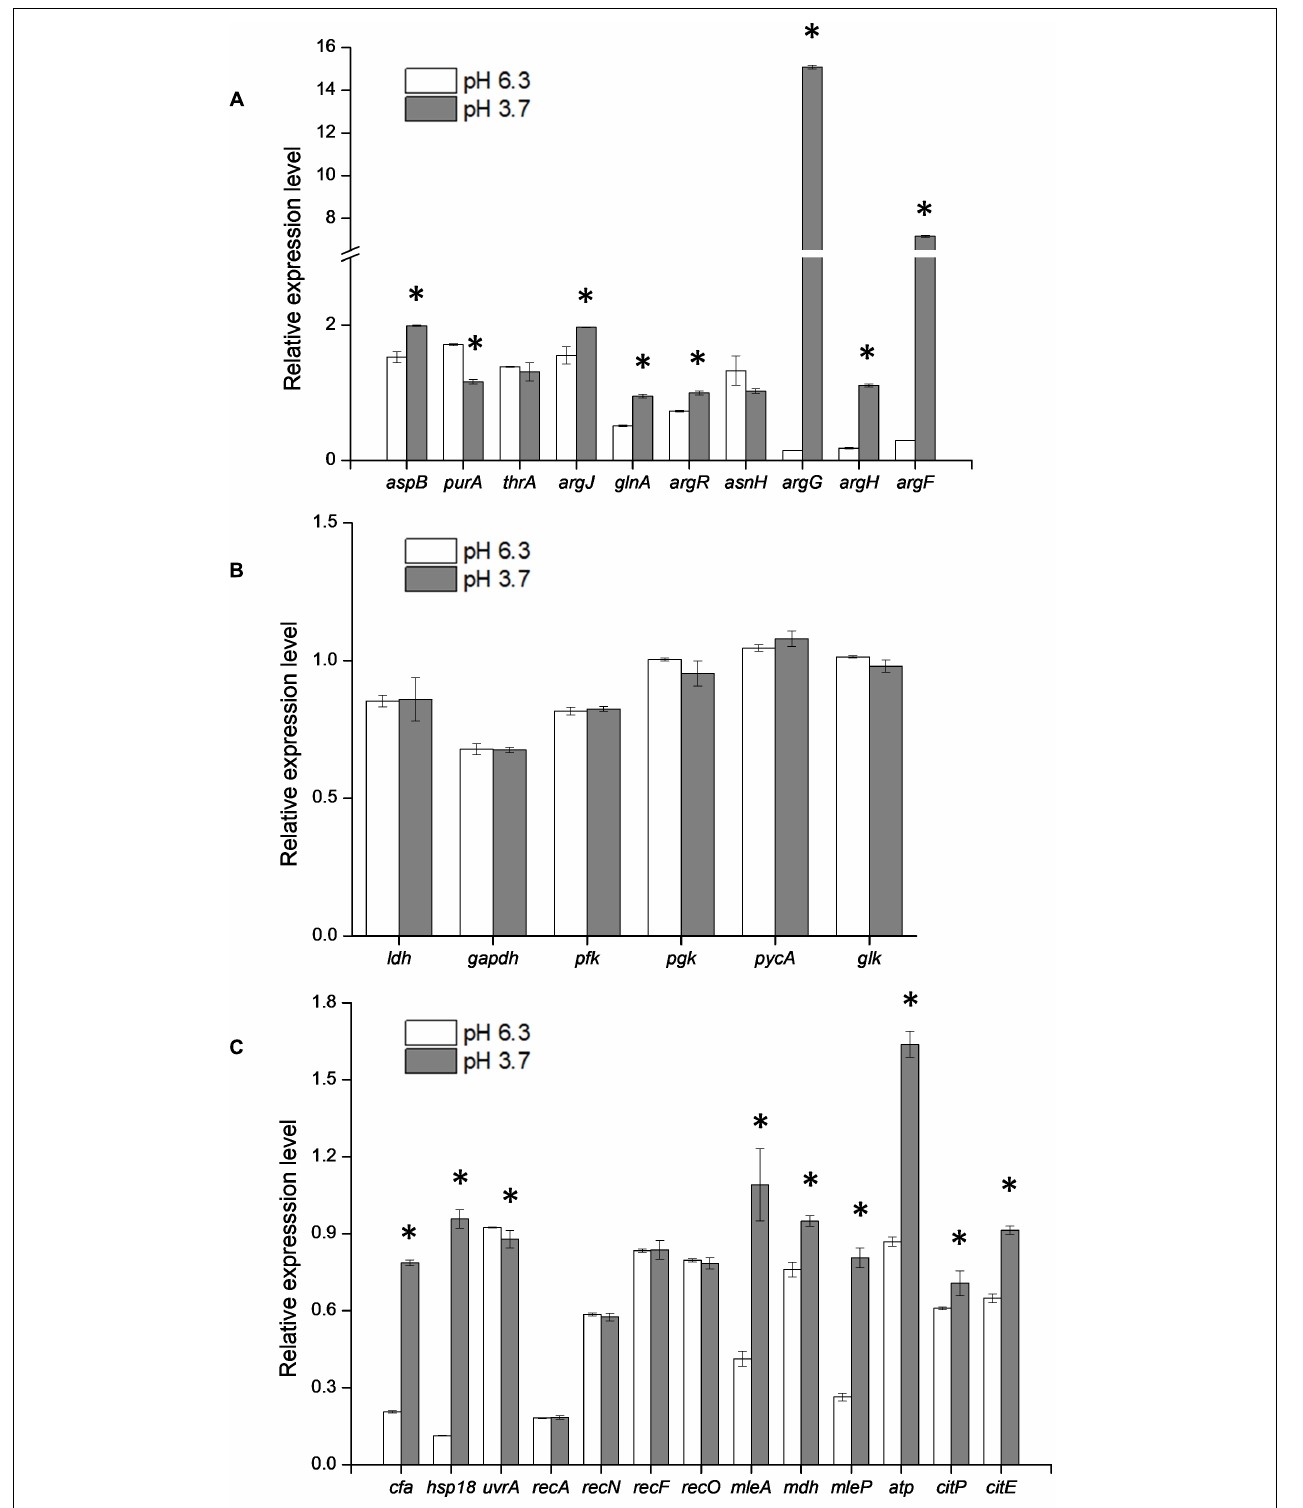
FIGURE 4 | Effect of argG gene heterologous expression on the transcription of amino acid metabolic genes (A) , glycolytic genes (B) , and other stress response genes (C) . ∗ Difference significant at 95% confidence level.